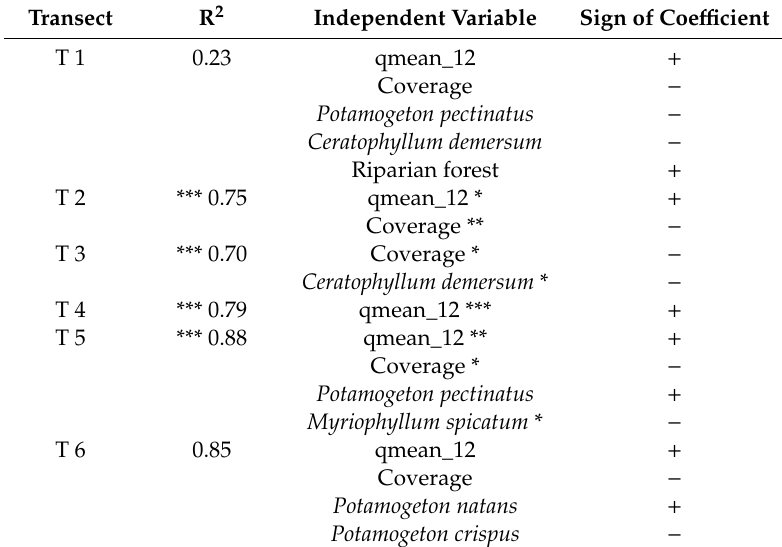
Table 4. Coe ffi cients of determination (R 2 ) of the general linear models (GLMs) for the di ff erent river transects (T) using ecological quality (IBICAT2010) as dependent variable and mean discharge (12-month period; “qmean_12”) and habitat variables as independent variables, through a stepwise selection procedure.